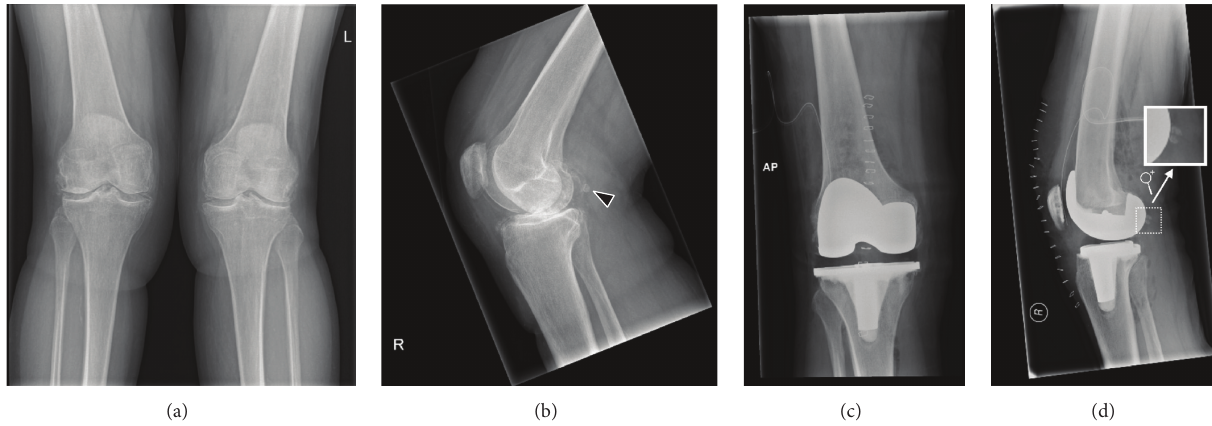
Figure 2: Preoperative (a, b) and immediate postoperative (c, d) knee radiographs in a 68-year-old woman who underwent total knee arthroplasty of the right knee because of symptomatic knee osteoarthritis with valgus malalignment. Preoperative knee radiographs (anterior- posterior view of both knees (a) and lateral view of the right knee (b)) show osteophytes, sclerotic changes, and some degree of generalized joint space narrowing on both sides, in keeping with femorotibial osteoarthritis. There is approximately 10 ∘ valgus malalignment of the right kneeandapproximately14 ∘ valgusmalalignmentoftheleftknee.Notethenormalappearingfabella((b)arrowhead).Immediatepostoperative radiographs of the right knee on the same day of surgery (anterior-posterior view (c) and lateral view (d)) show not only a good position of the total knee arthroplasty with a well-aligned knee joint but also a horizontal fracture through the fabella with only minimal dislocation ((d) including magnified view of the